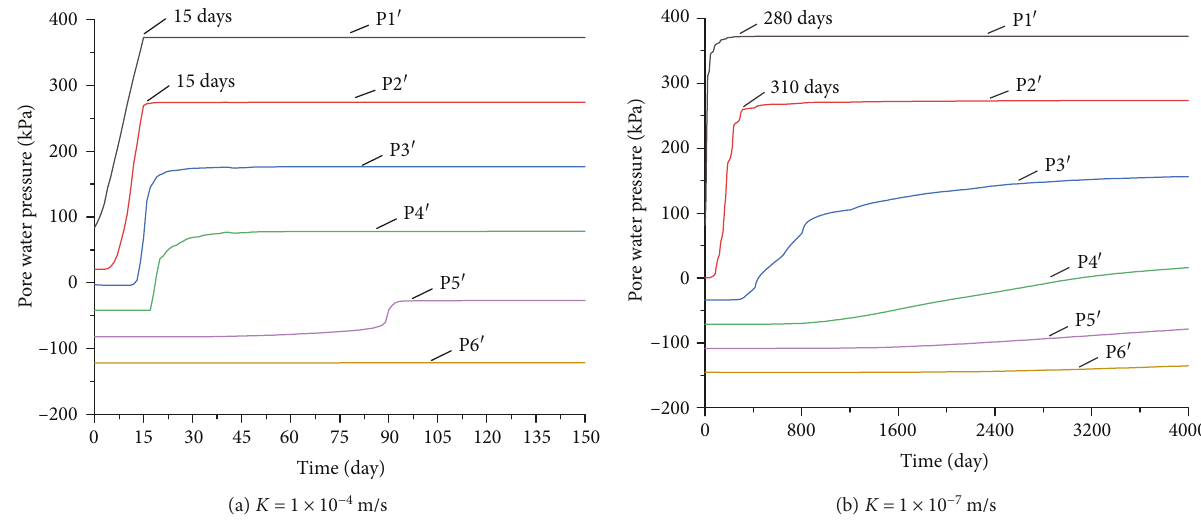
Figure 17: Pore water pressure of P1 ′ ~ P6 ′ versus time in numerical tests ( waterlevelrising rate = 2m/day